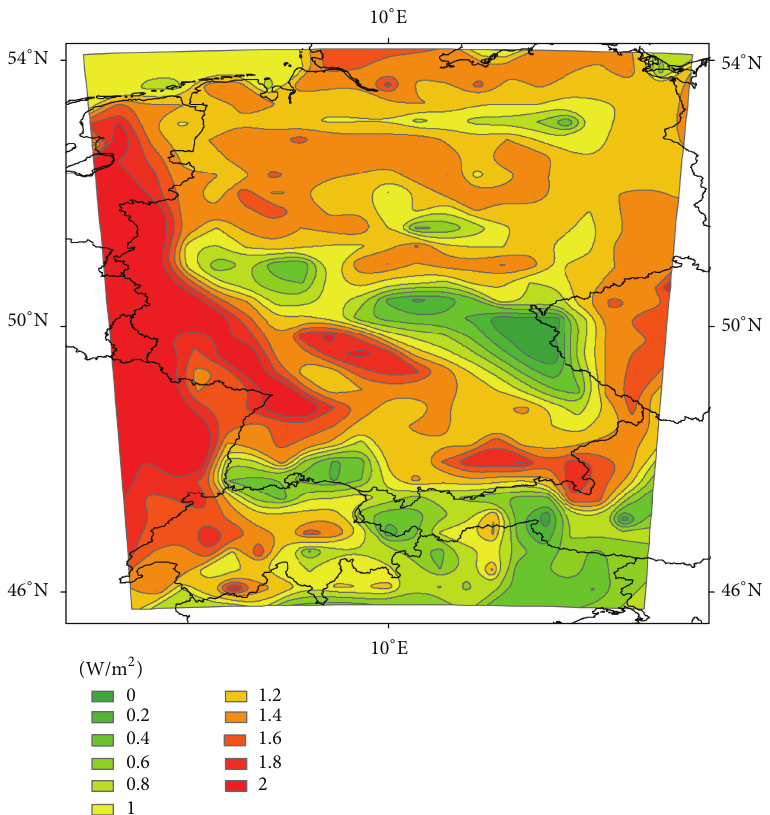
Figure 6: Annual changes of projected latent heat flux in Central Europe,